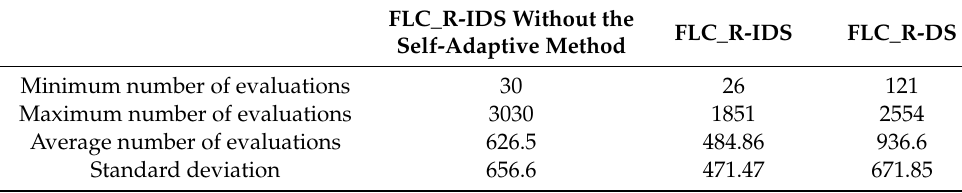
Table 3. Comparison between the evaluation numbers of various existing models in the learning process.